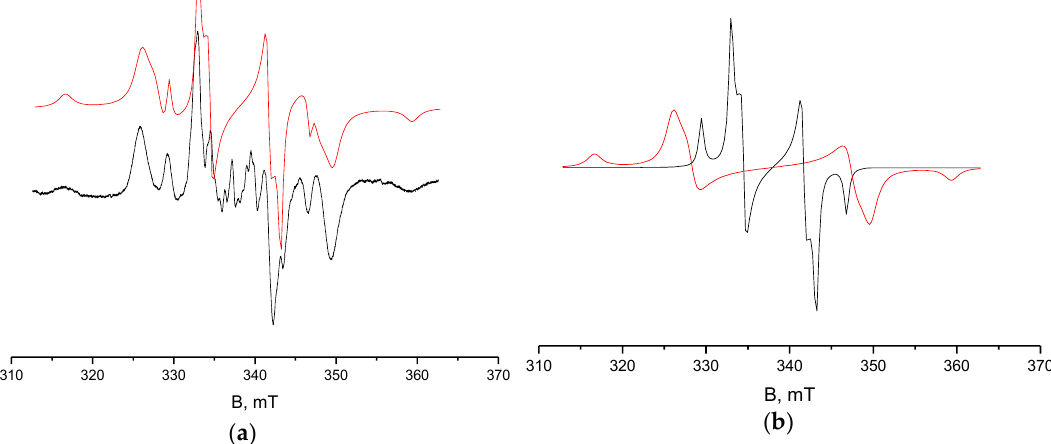
Figure 3. The electron spin resonance (ESR) spectrum of diradical 1 in a diluted glassy solution: experiment ( a ) and modeling ( b ).